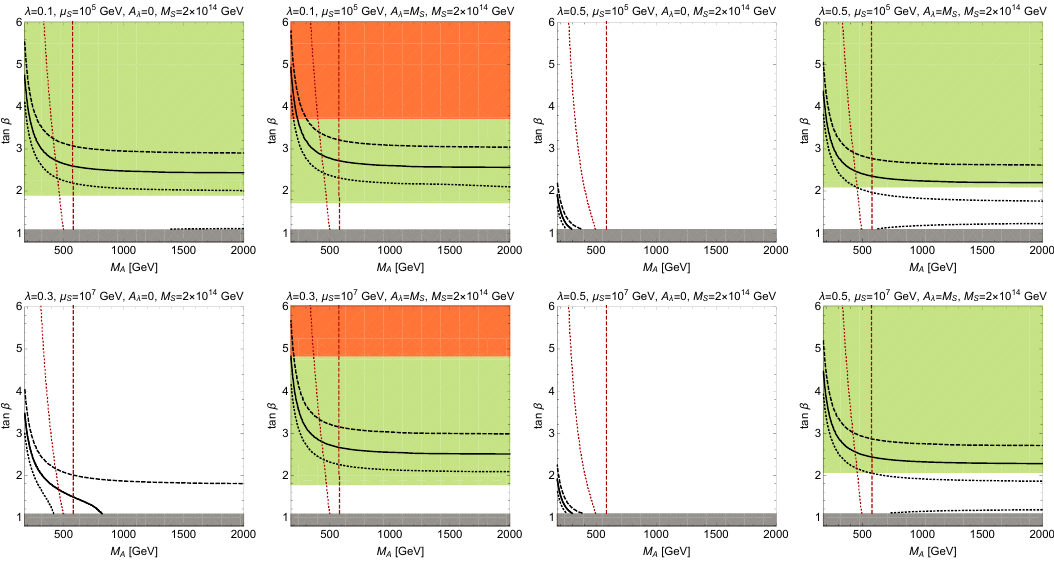
Figure 7 . Same as (cid:12)gures 4, 5 but for M